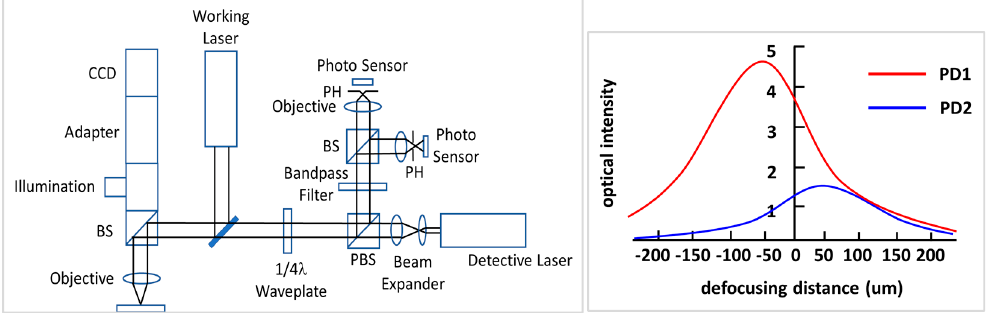
Figure 1. The schematic diagram of the dual-confocal system [41].